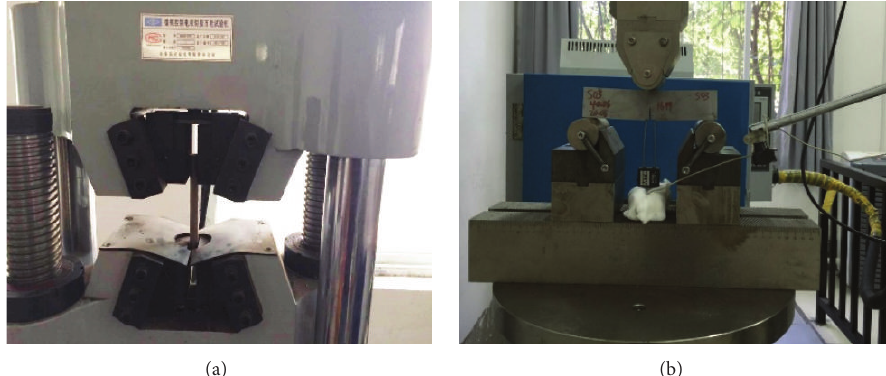
Figure 3: Test facilities: tensile (a) and fracture toughness (b) testing systems.